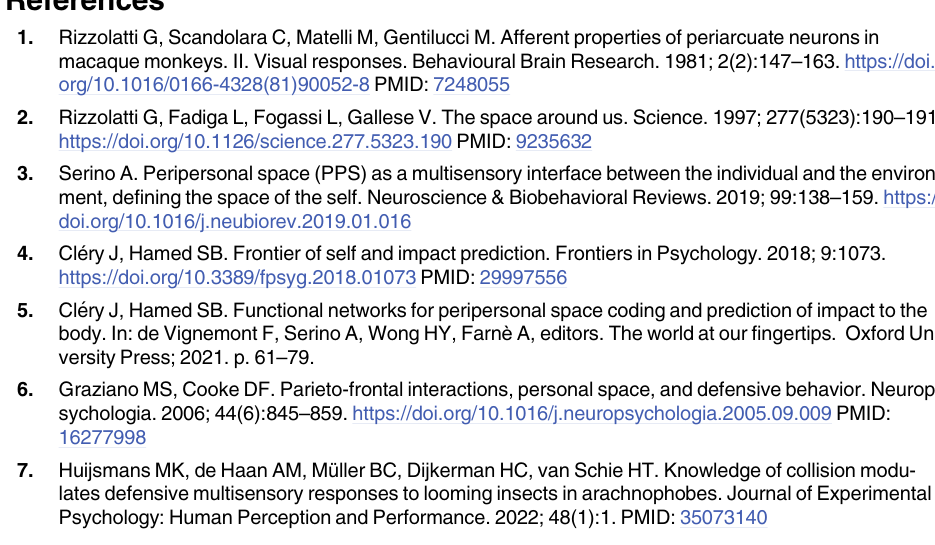
= 0 cm , the baseline parameters (see Table 1) were used. See the code for details. FN and σ x S7 Fig. Effect of timestep Δ T size on PPS. Dependency between the mean of 1000 predicted tactile activations y � (for each distance) and distance x (in centimeters) of the stimuli from T pred the body. The symbol “+” indicates 25th and 75th percentiles which are calculated from 1000 predicted values y � for each distance. PPS size expands with increasing size of timestep Δ T pred (in seconds). Sharpness of the PPS boundary is decreasing with increasing size of timestep Δ T . Except for Δ T , baseline parameters are used (Table 1). S8 Fig. A version of S7 Fig with FN = FP =